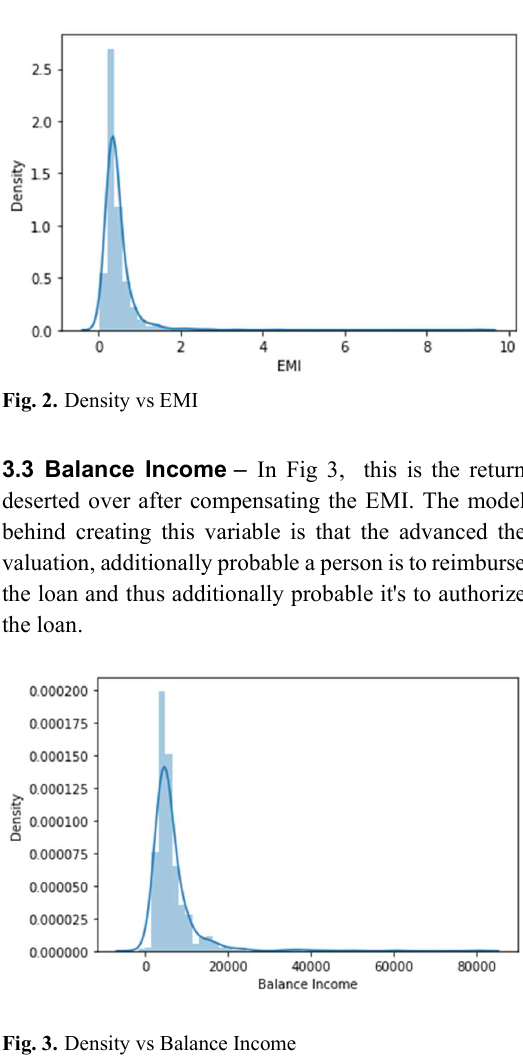
Fig. 3. Density vs Balance